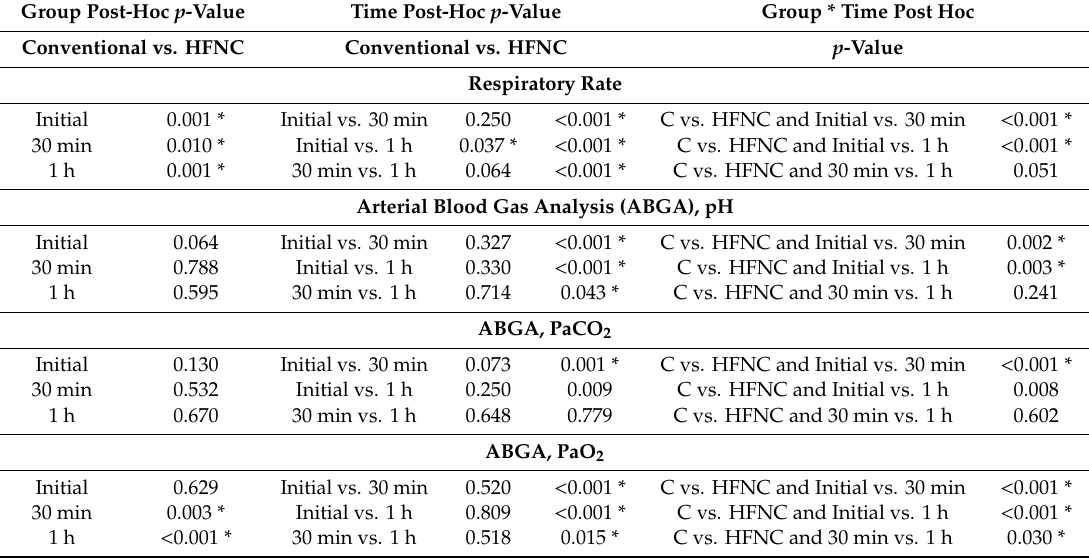
Table 3. Post hoc analysis to estimate the time points at which the treatment effects differed between the 2 groups.